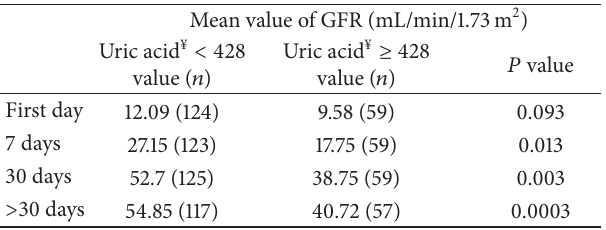
Table 3: Mean GFR value on different time intervals after renal